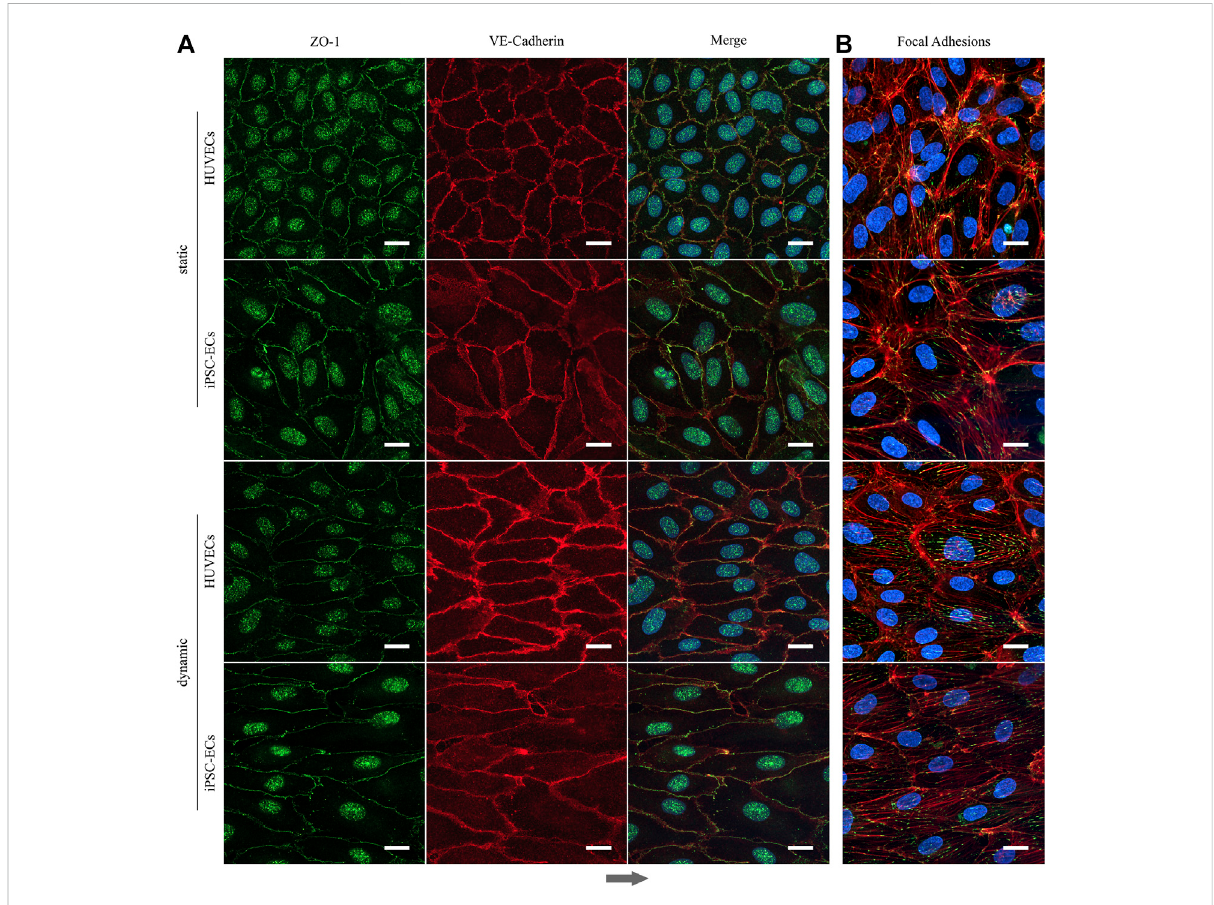
FIGURE 9 Formation of tight junctions and appearance of focal adhesion after static and dynamic culture of HUVECs and iPSC-ECs for 96 h. (A) RepresentativeconfocalimagesofZO-1(green)andVE-Cadherinstaining(red).NucleiwerecounterstainedwithHoechst33342(blue). (B) Confocal images of phalloidin (red) and vinculin staining (green) representing the focal adhesions. Nuclei were counterstained with Hoechst 33342 (blue). (Arrow indicates fl ow direction. Scale bars: 20